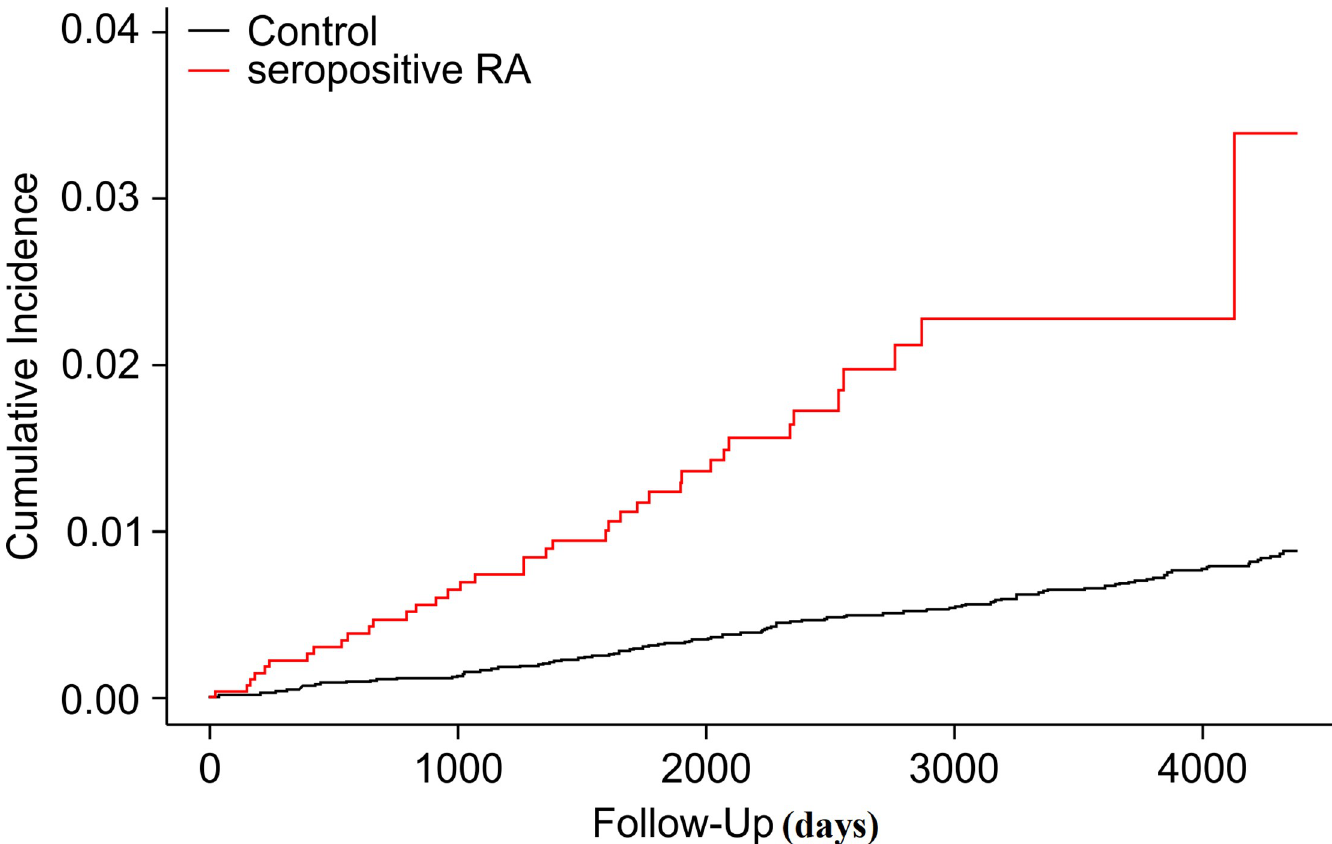
Fig 2. Comparison of the cumulative incidence of ischemic stroke in the seropositive RA and control groups. The Kaplan–Meier curves with cumulative hazards of ischemic stroke were compared between seropositive RA and control groups ( p = 0.014).